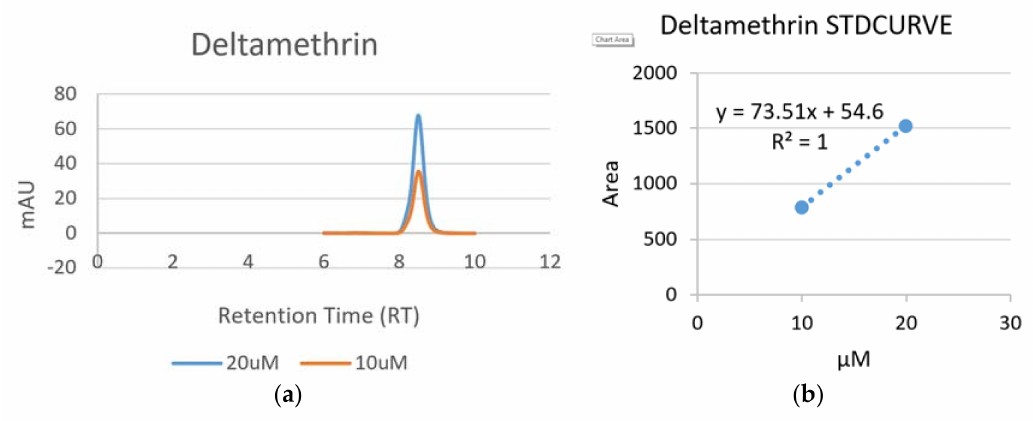
Figure 3. Chromatogram ( a ) and standard curve ( b ) of